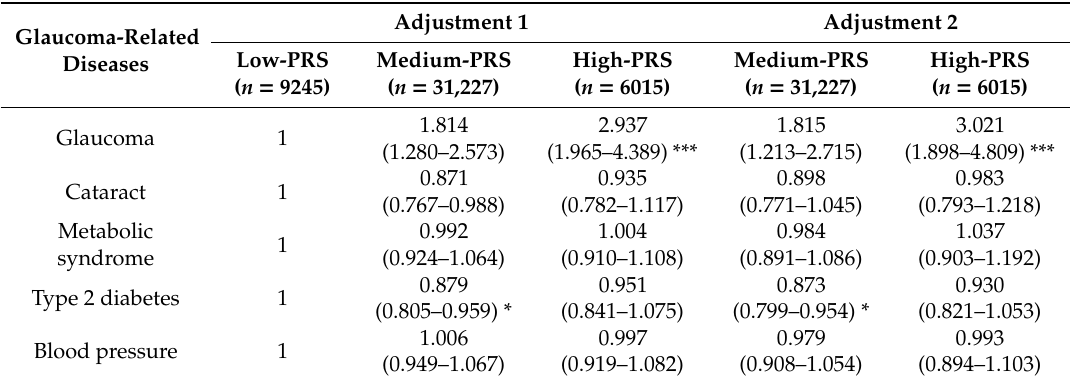
Table 4. Adjusted odds ratios for glaucoma, age-related cataract, and metabolic syndrome according to the polygenetic risk scores (PRS) of the best model for gene-gene interaction after covariate adjustments.